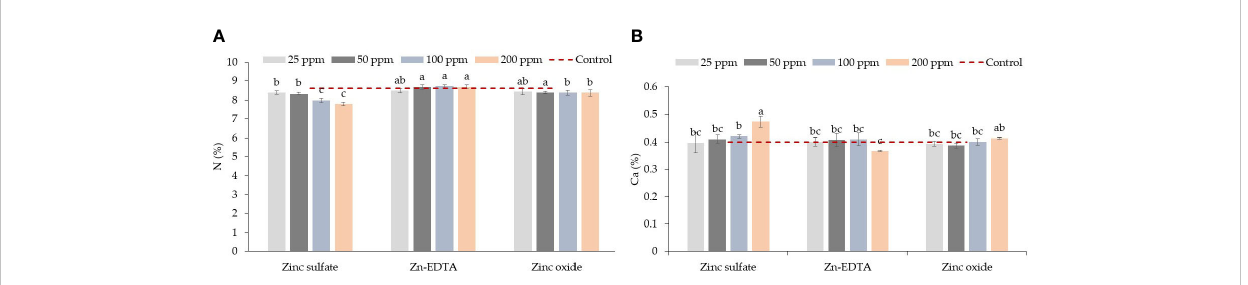
FIGURE 2 Zinc source and application rate interaction effect on total N (A) and Ca (B) content in pea microgreens (% on a dry weight basis). Vertical bars indicate average values and the standard error ( n = 3). Different letters indicate signi fi cant differences at p = 0.05 by the Fisher LSD test. The dashed line indicates the average value of the untreated control.